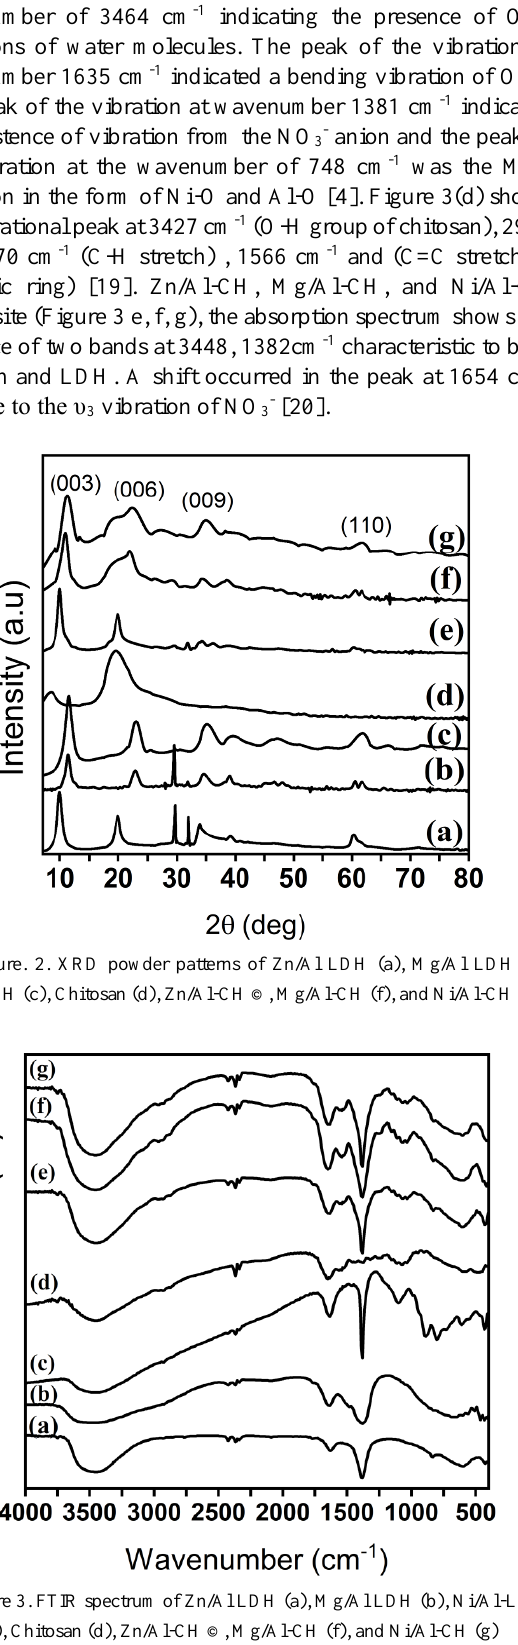
Figure 3. FTIR spectrum of Zn/Al LDH (a), Mg/Al LDH (b), Ni/Al-LDH (c), Chitosan (d), Zn/Al-CH ©, Mg/Al-CH (f), and Ni/Al-CH (g)